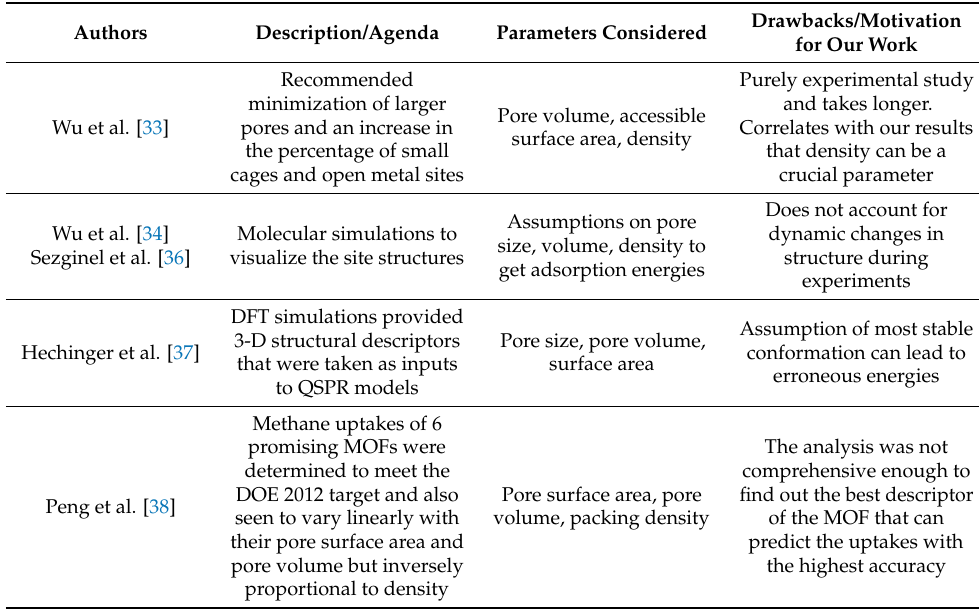
Table 1. Main agendas and drawbacks of the most important research works involving various computational techniques in methane